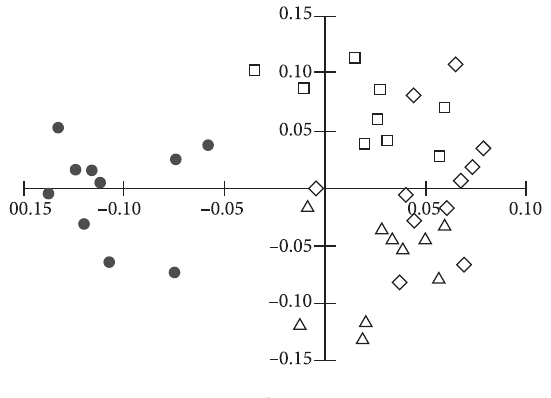
Fig. 2. Scatter diagram of samples according to the sites of the four considered land cover